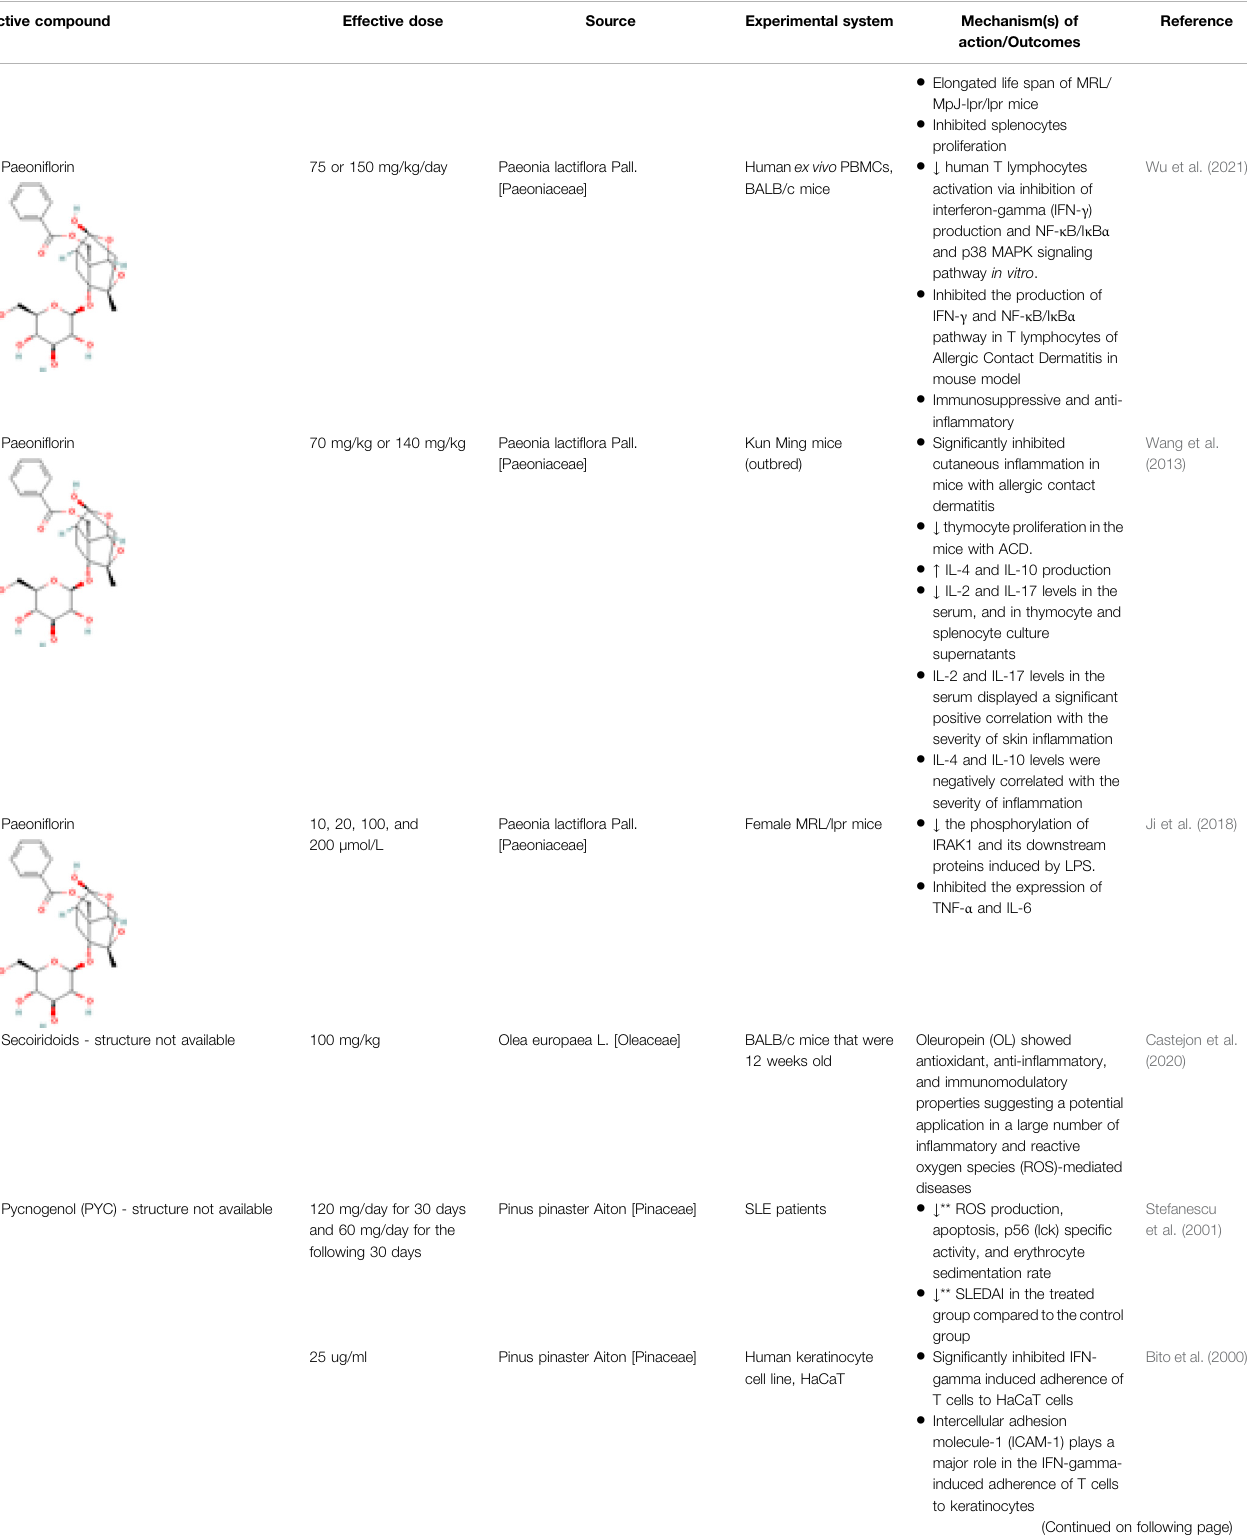
TABLE 1 | ( Continued ) Synthesized fi ndings for potential bioactive compounds for